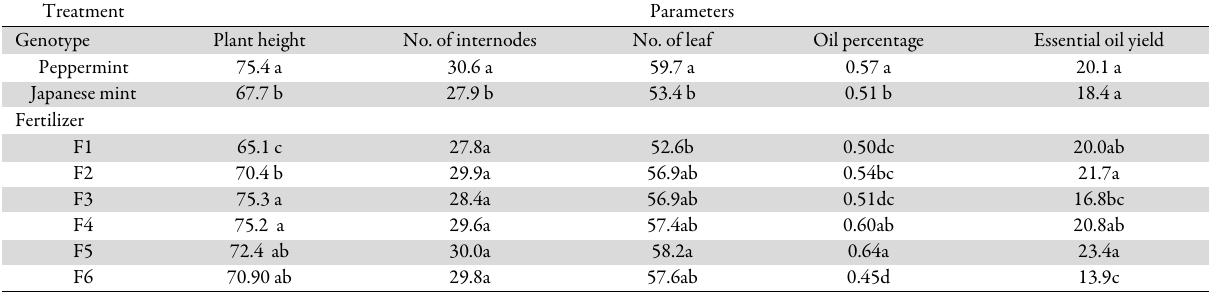
Table 3. Main effects of genotype and fertilizer regimes on yield and yield components of mint